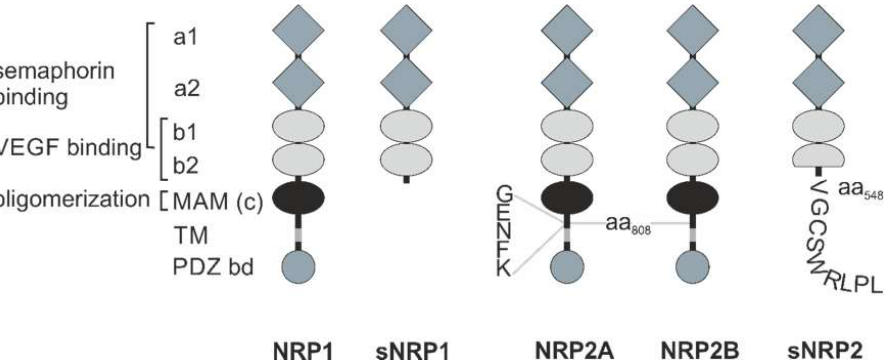
Cubilin homology (CUB) domains, termed a1 and a2 (grey diamonds), two factor V/VIII homology domains, termed b1 and b2 (light grey ellipses), a linker region, and a meprin/A5-protein/receptor protein-tyrosine phosphatase mu, or for short, MAM or c domain (black ellipse). Via a single transmembrane (TM) domain (grey) it is linked to a cytoplasmic domain containing a C-terminal PSD-95/Dlg/ZO-1 (PDZ) binding domain motif (dark grey circle) with the characteristic amino acid